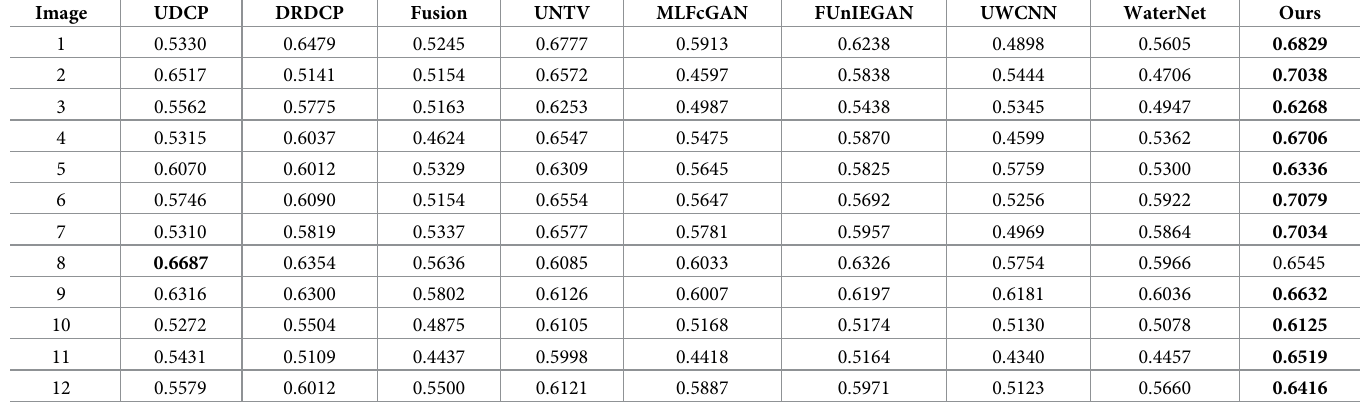
Table 1. Quantitative evaluation results of UCIQE index.